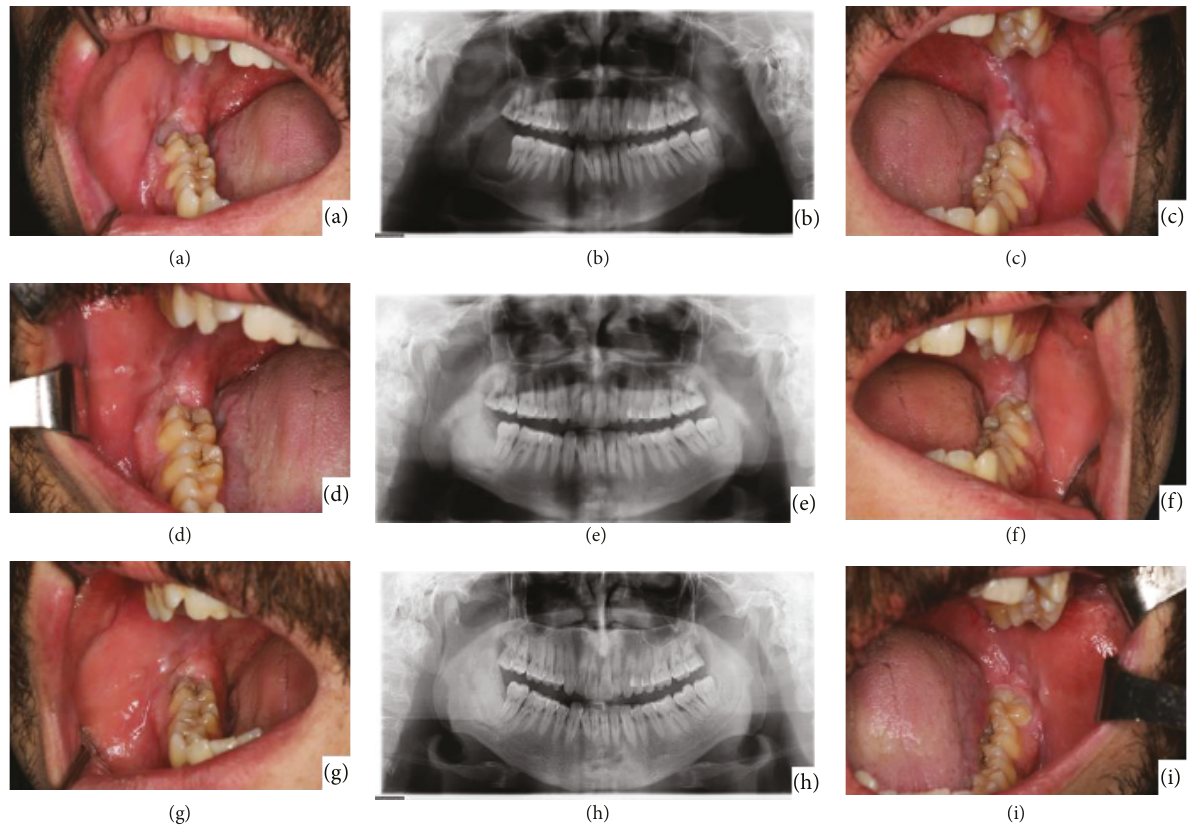
Figure 4: (a) Six months of follow-up: panoramic radiography of bilateral brown tumors. Notice to decreased radiolucency for the brown tumor in the bilateral sides of the mandible. (b) Six months of follow-up: intraoral appearance of the brown tumor (right side). (c) Six months of follow-up: intraoral appearance of the brown tumor (left side). (d) Second year of follow-up: panoramic radiography of bilateral brown tumors. Notice not to observe recurrence for brown tumors in the bilateral sides of the mandible. (e) Second year of follow-up: intraoral appearance of the brown tumor (right side). (f) Second year of follow-up: intraoral appearance of the brown tumor (left side). (g) Fourth year of follow-up: panoramic radiography of bilateral brown tumors. (h) Fourth year of follow-up: intraoral appearance of the brown tumor (right side). (i) Fourth year of follow-up: intraoral appearance of the brown tumor (left side). Notice to the left mandibular third molar eruption is almost